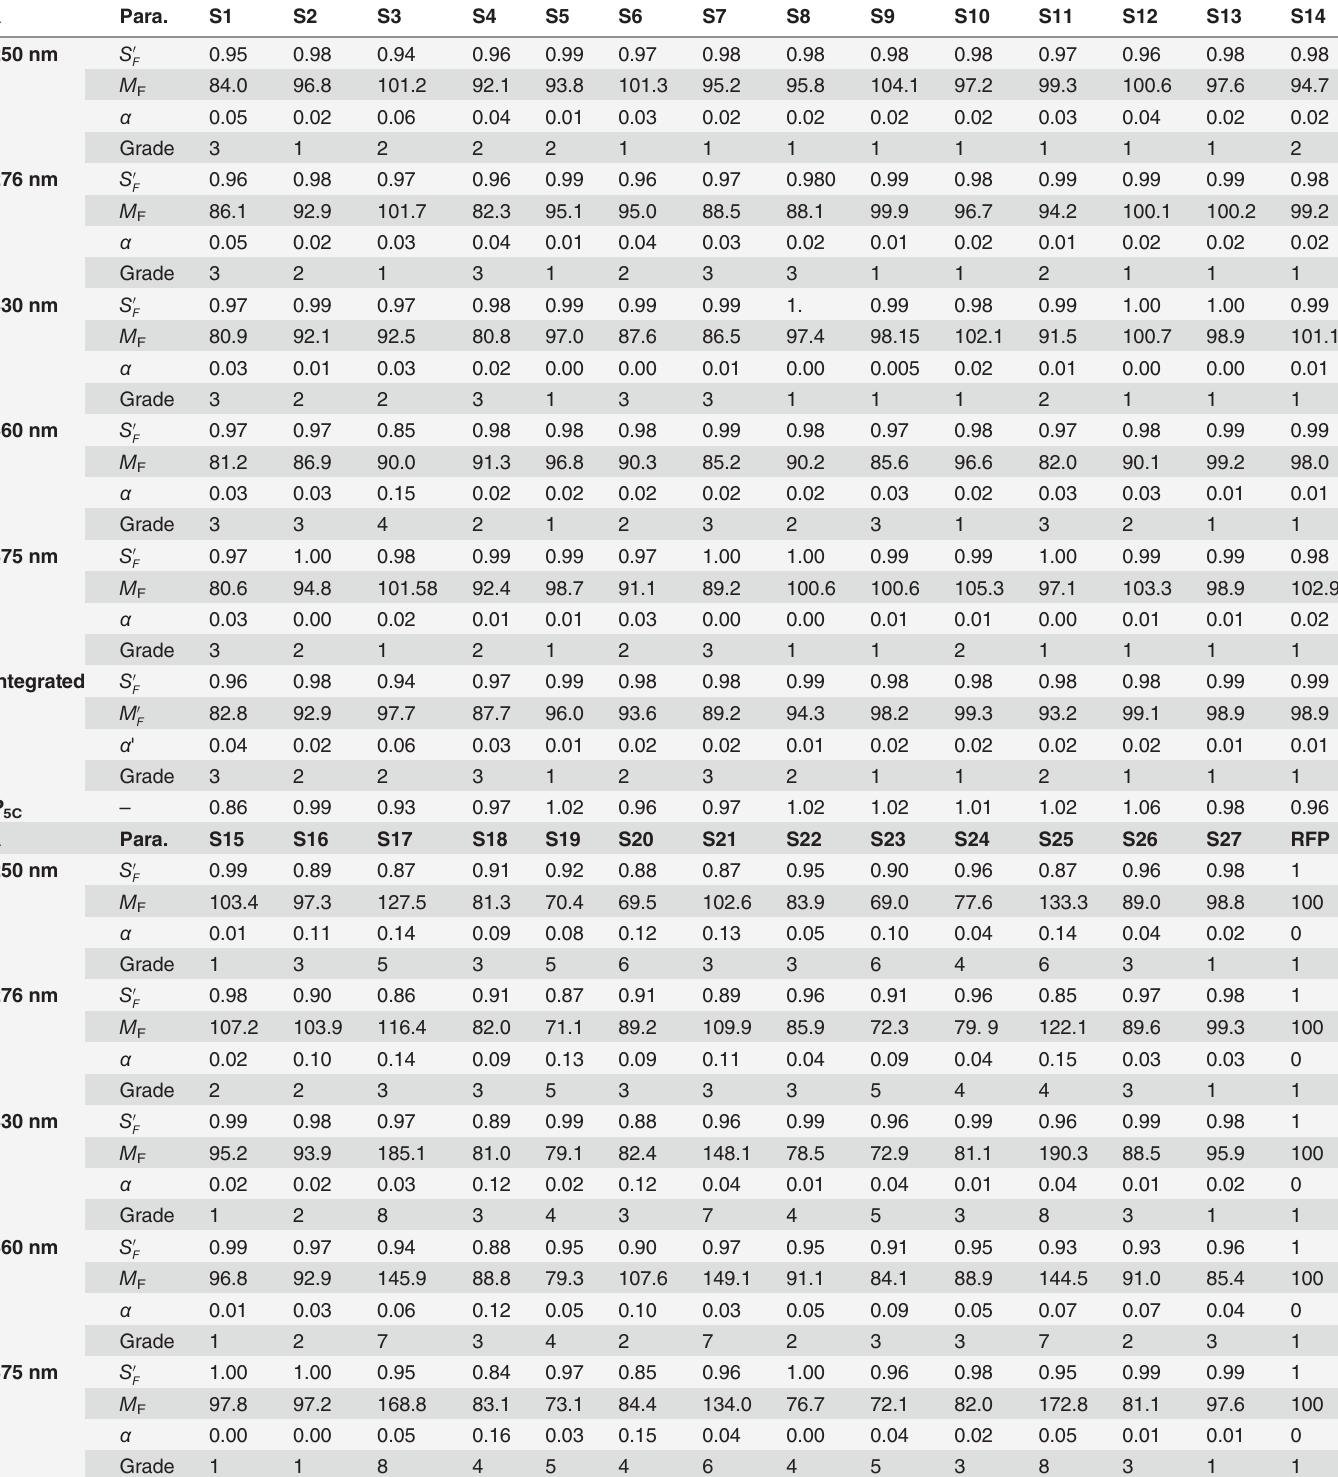
Table 2. The evaluation results of 27 CBAT samples by